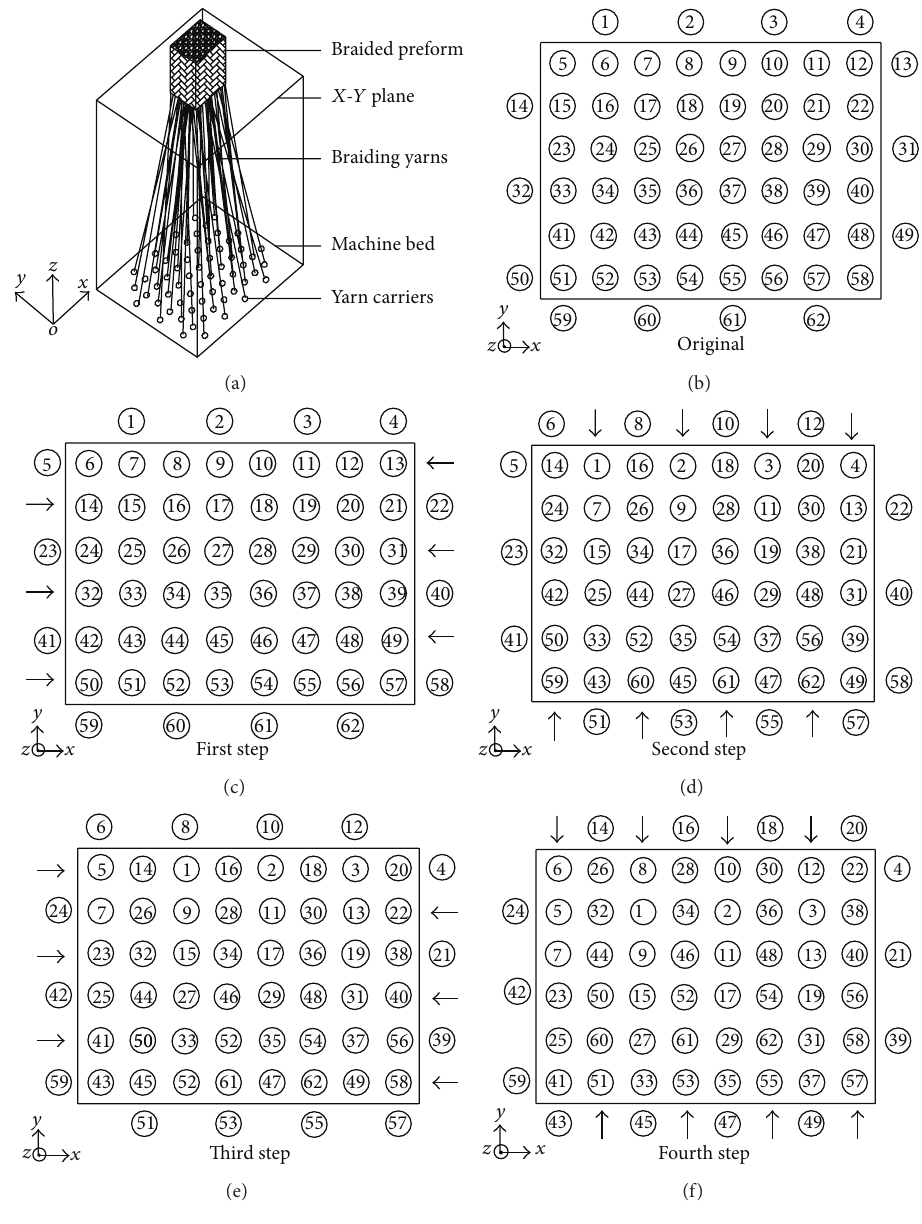
Figure 1: 3D four-step 1 × 1 braiding process